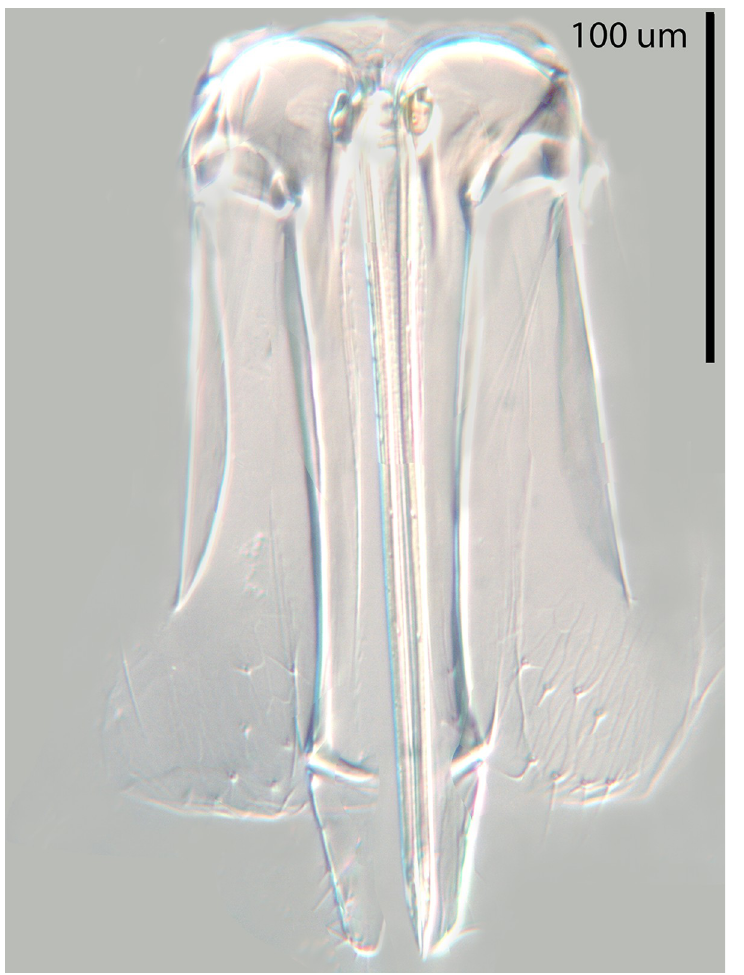
Fig 7. M . macadamiae female holotype,